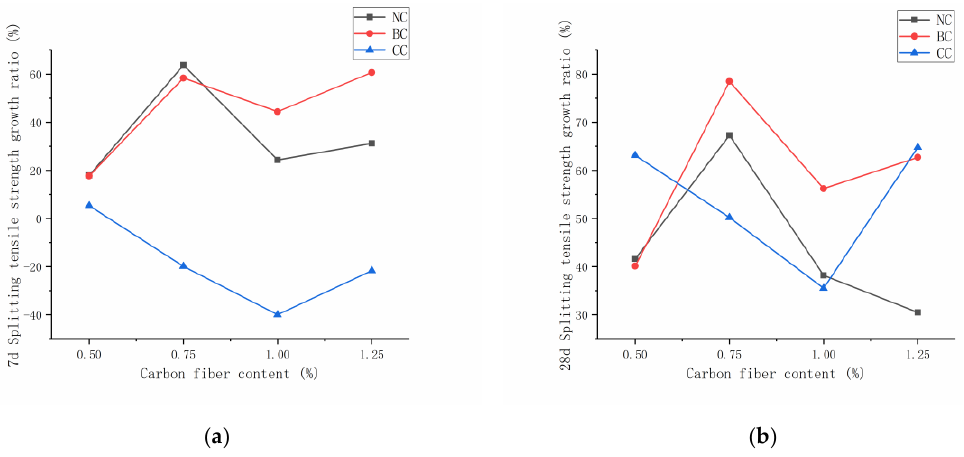
Figure 8. Splitting tensile strength growth ratio at seven days and 28 days: ( a ) seven days, ( b ) 28 days.